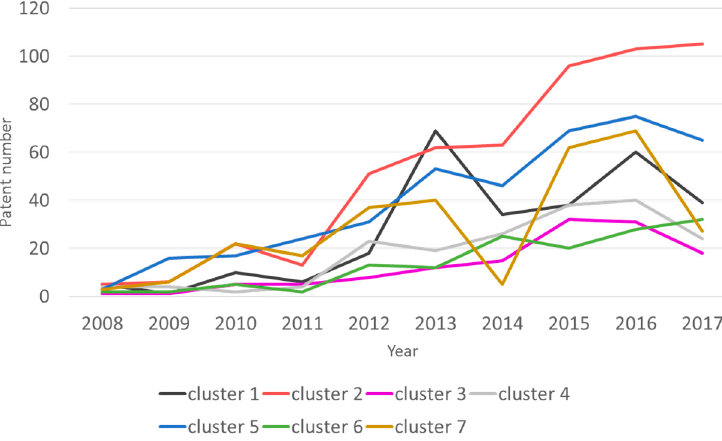
Figure 10. Patent trend of all clusters.